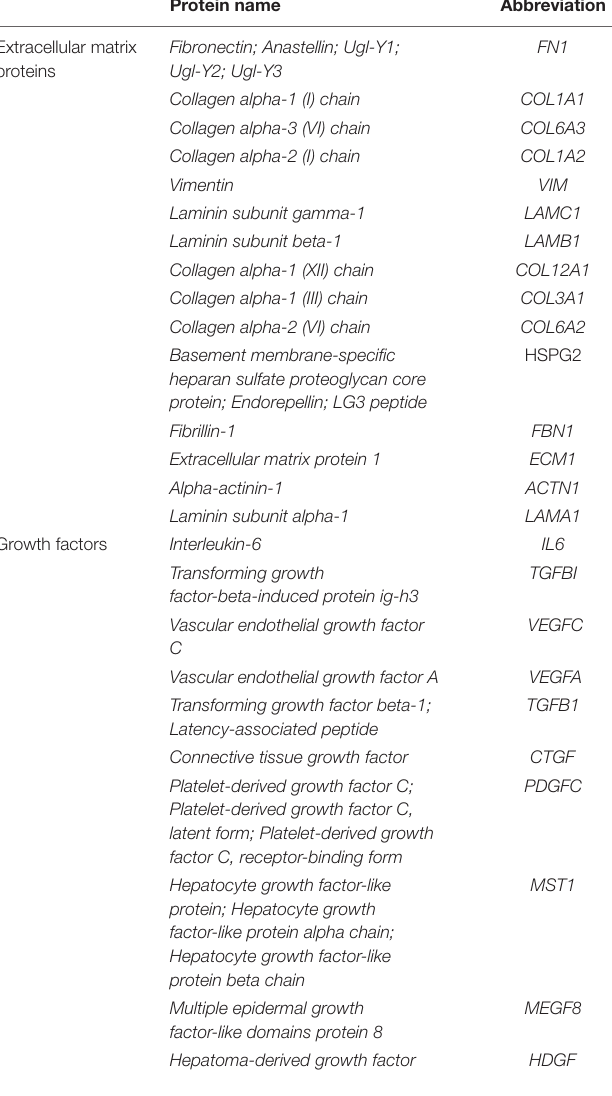
TABLE 2 | The representative extracellular matrix proteins and growth factors among the identified secreted